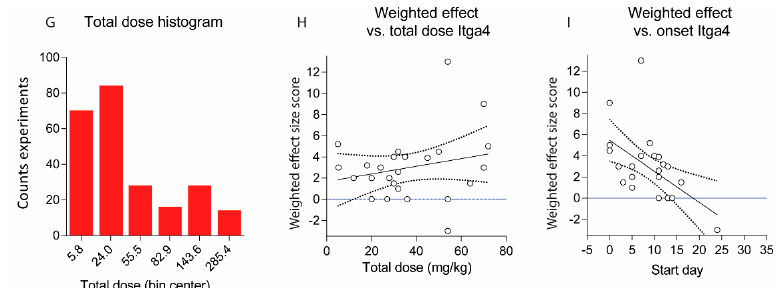
Figure 5. ( A ) Scatter plots showing the weighted effect size scores of experiments with different treatment regimens. The effect size score ranges from 6 (very strong reduction of EAE scores) to 0 (no effect) and is negative ( − 1 or − 2) if the antibody aggravated the disease. The scores were weighted according to the number of animals per treatment group ( n ) by multiplication of the effect size with n /10; ( B ) Association of weighted effect size scores with the day of onset of the treatment. The line shows the linear regression plus 95% CI (dotted lines), not significant (n.s); ( C ) Weighted effect size scores for studies, which directly compared early (preventive or pre-onset) and late (onset, post-onset and late) therapeutic regimens. For three different schedules, the earliest and latest were used. For studies with 4 schedules 2 pairs were used. There was no association between onset of therapy with the effect size, Wilcoxon matched-pairs signed rank test, p = 0.2406; ( D ) Association of weighted effect size scores with the total dose in mg/kg for C57Bl6 and SJL/J mice and rats. Mice with mixed backgrounds are included. If the dose was given in µg per animal, the amount in mg/kg was estimated based on a body weight of 25 g per mouse, 300 g per Lewis rat and 200 g per dark agouti (DA) rat; ( E ) Association of weighted effect size scores with the single dose in mg/kg. The line shows the linear regression plus 95% CI (dotted lines), n.s; ( F ) Weighted effect size scores for studies, which directly compared 2 or more different doses. For studies with 3 doses the lowest and highest were used. Each line represents one study. Overall, there was no dose-effect relationship, Wilcoxon matched-pairs signed rank test, p = 0.4493; ( G ) Histogram of total doses in mg/kg including all experiments; ( H ) Association of weighted effect size scores with the total dose in mg/kg for experiments targeting VLA-4 (Itga4/Itga2 dimer) with Itga4 antibodies. The line shows the linear regression plus 95% CI (dotted lines), n.s; ( I ) Association of weighted effect size scores with the day of treatment onset for experiments targeting VLA-4 (Itga4/Itga2 dimer). The line shows the linear regression plus 95% CI (dotted lines). The slope of the regression line differed significantly from zero, p = 0.0046.